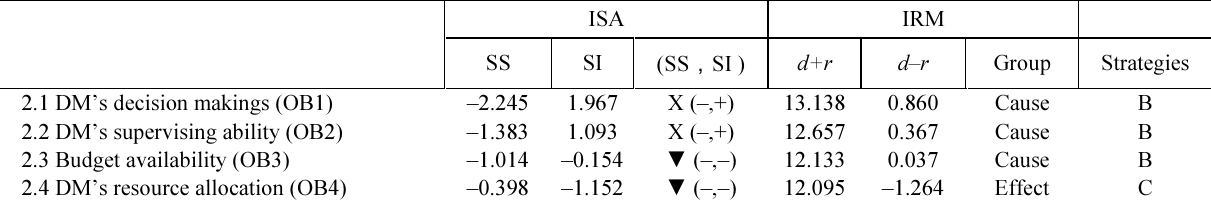
Table 14. Strategies for improving second-level delay factors under OB factor